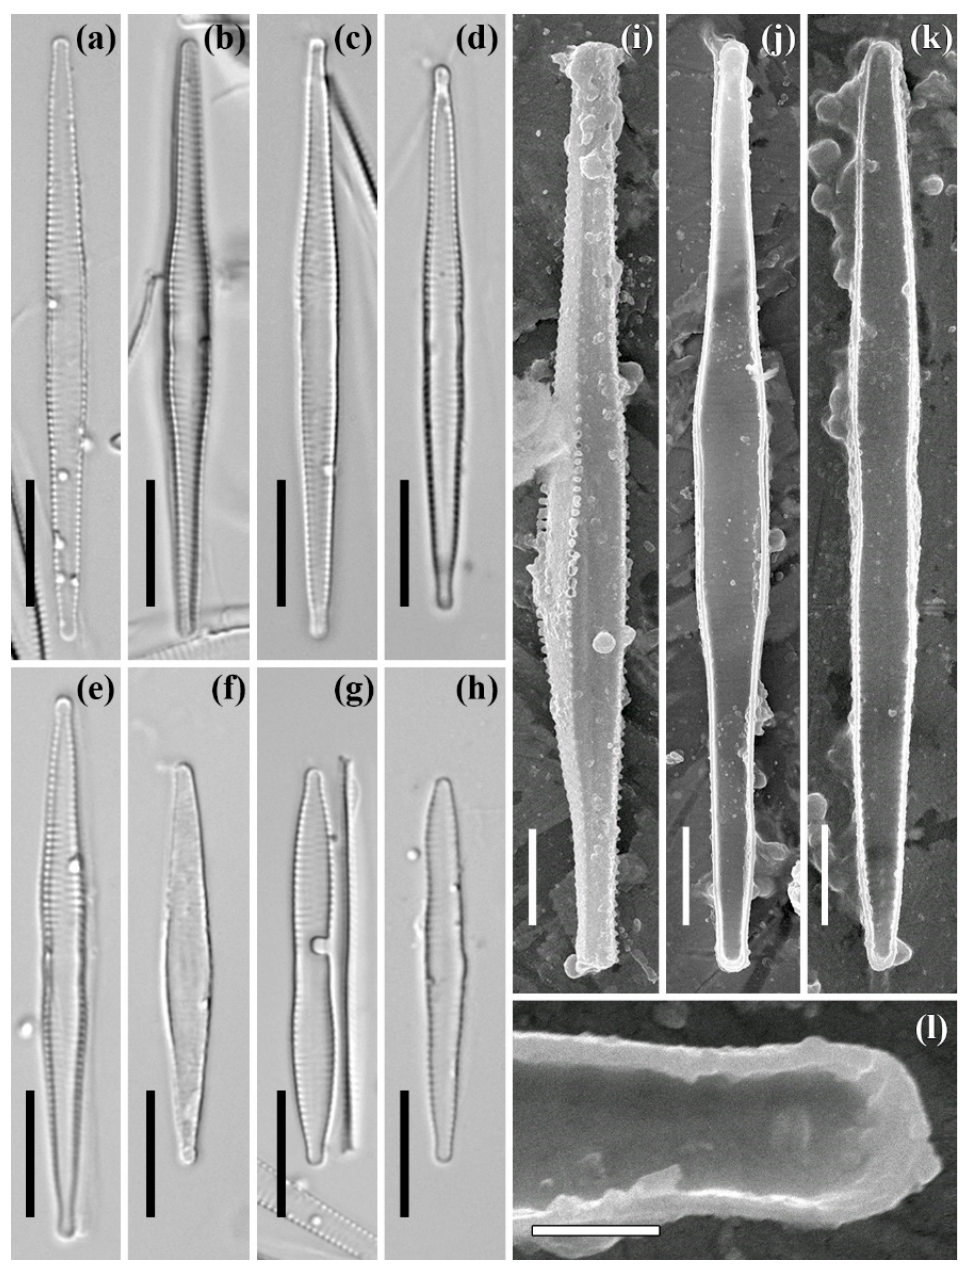
Figure 2. Fragilaria cf. crotonensis Kitton. Strain ARC03. Slide no. 08440. LM, DIC ( a – h ). SEM: ( i ) external view, ( j – l ) internal view. ( a – h ) size diminution series, ( i – k ) general view, ( g , h ) valve end. Scale bars: 10 µ m ( a – h ), 5 µ m ( i – k ), 1 µ m ( l ). The SEM , external views are shown in Figure 3i,j. A central annulus is present. Cen- tral outgrowths are absent (Figure 3i). The striae are uniseriate at the valve center, becom- ing tri-seriate near the valve mantle (Figure 3i,j). The areolae number 35–37 in 10 µ m (in one row). There are spines between each fascicle, positioned at the valve face/mantle junction (Figure 3i,g). The fultoportulae are open with tubes located under the spines (Figure 3j). The SEM , internal view is shown in Figure 3k. The valve surface is flat. The fultopor- tulae are well developed, and their tubes have three satellite pores. The only rimoportula is located on the valve mantle. The ripomortula lips are well expressed. The specimens shown are slide no. 08442, stub no. ARC 05 (oxidized material of culture strain ARC 05, isolated in sample no. 3935 from the Gulf of